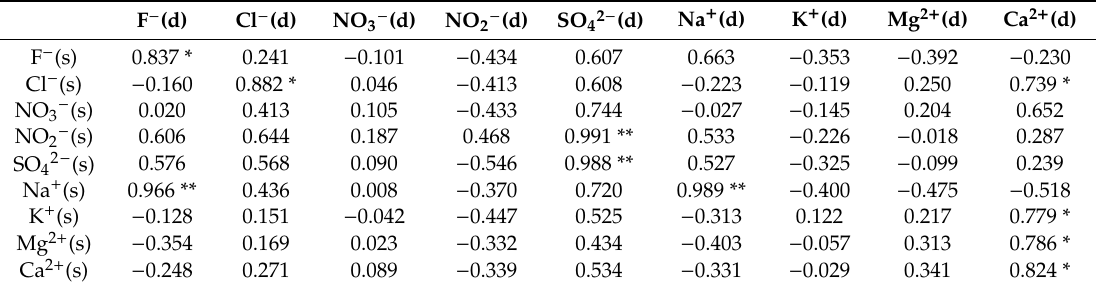
Table 3. Correlation coe ffi cients of WSIIs in dustfull and topsoil.